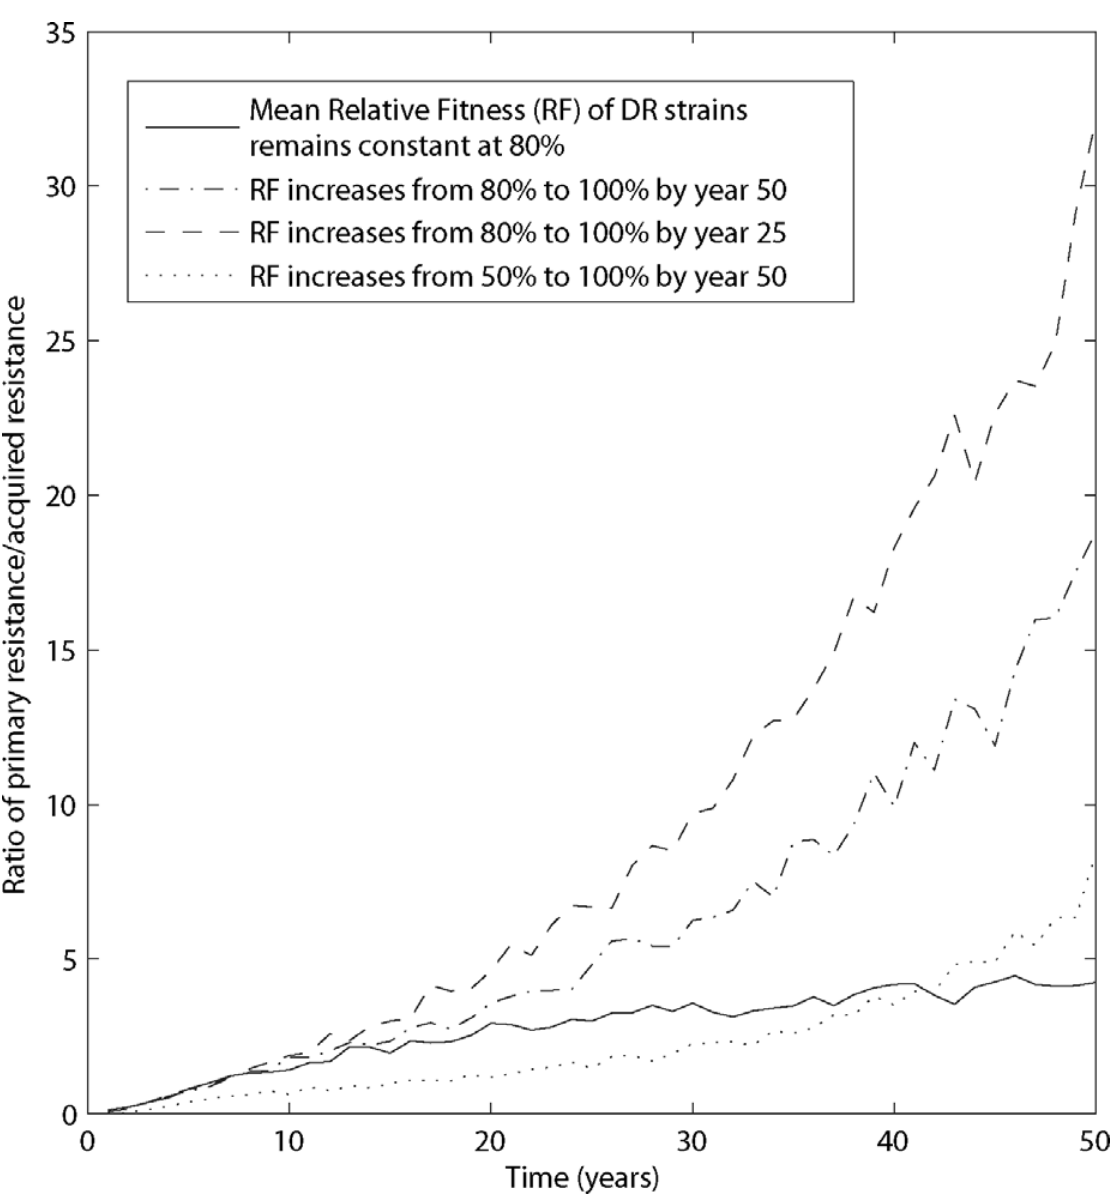
Figure 5. Dominant mechanisms driving resistance change as the epidemic progresses. The mean of the ratio of transmitted to acquired resistance is plotted over 50 years of a simulated epidemic. The rate of increase in this ratio depends on how the relative fitness of resistant strains change over time: four examples are provided, in which the relative fitness of strains remains constant at 80%, increases from 80 to 100% over 50 years, increases from 80 to 100% over 25 years, and increases between 50 and 100% over 50 years, respectively.